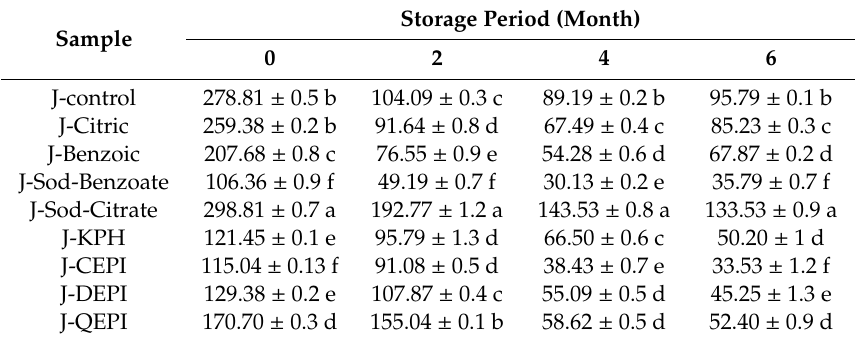
Table 3. Changes of total sugars during storage for zero and six months, at room temperature.